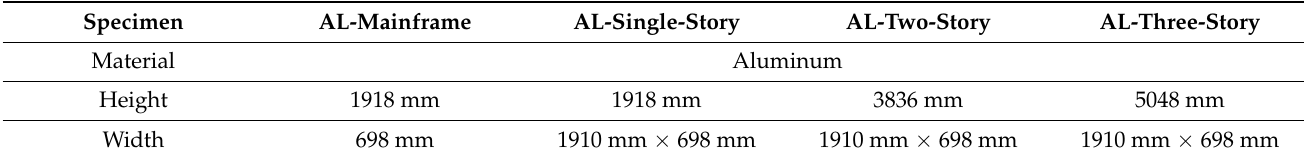
Table 12. Specification of fabricated mobile scaffolds.